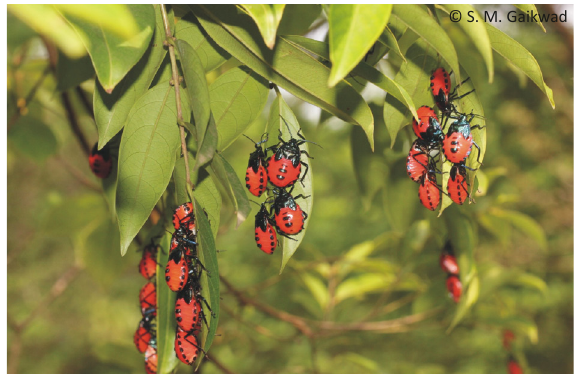
Image 2. Aggregation of Catacanthus incarnatus - nymphs on I.